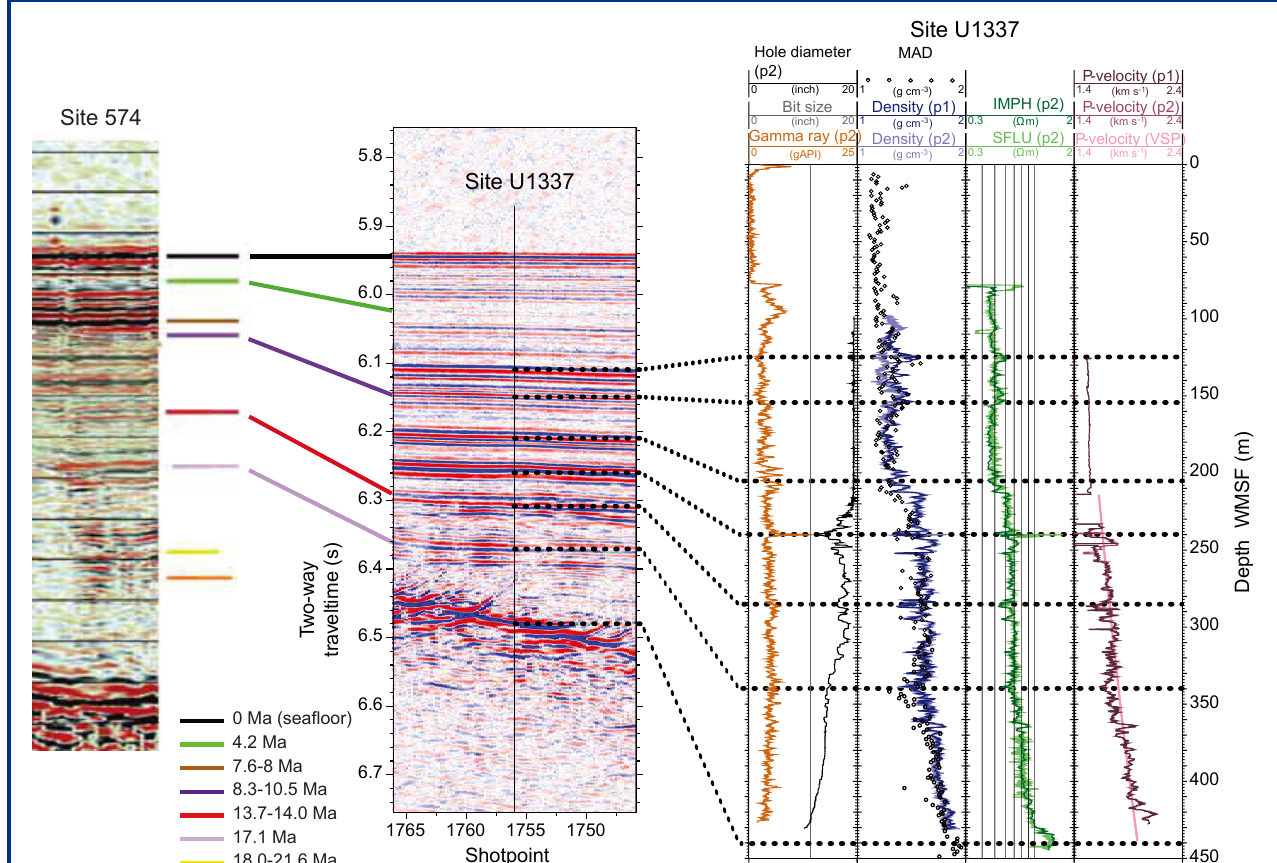
Figure 8. Correlation between the seismic reflection records from DSDP Leg 85 Site 574, IODP Expedition 321 Site U1337 (line 4 of the AMAT-03 site survey in the PEAT-7 area), and logging data from Hole U1337A. Correlations between the seismic profile at Site U1337 and the logs are based on velocities from VSP experiments and those measured by the velocity log, as well as the correlations to the age of sediments associated with the sediment physical property anomalies. The seismic horizons are associated with major fluctuations of carbonate; they appear to be chronostratigraphic, as originally suggested by Mayer et al.